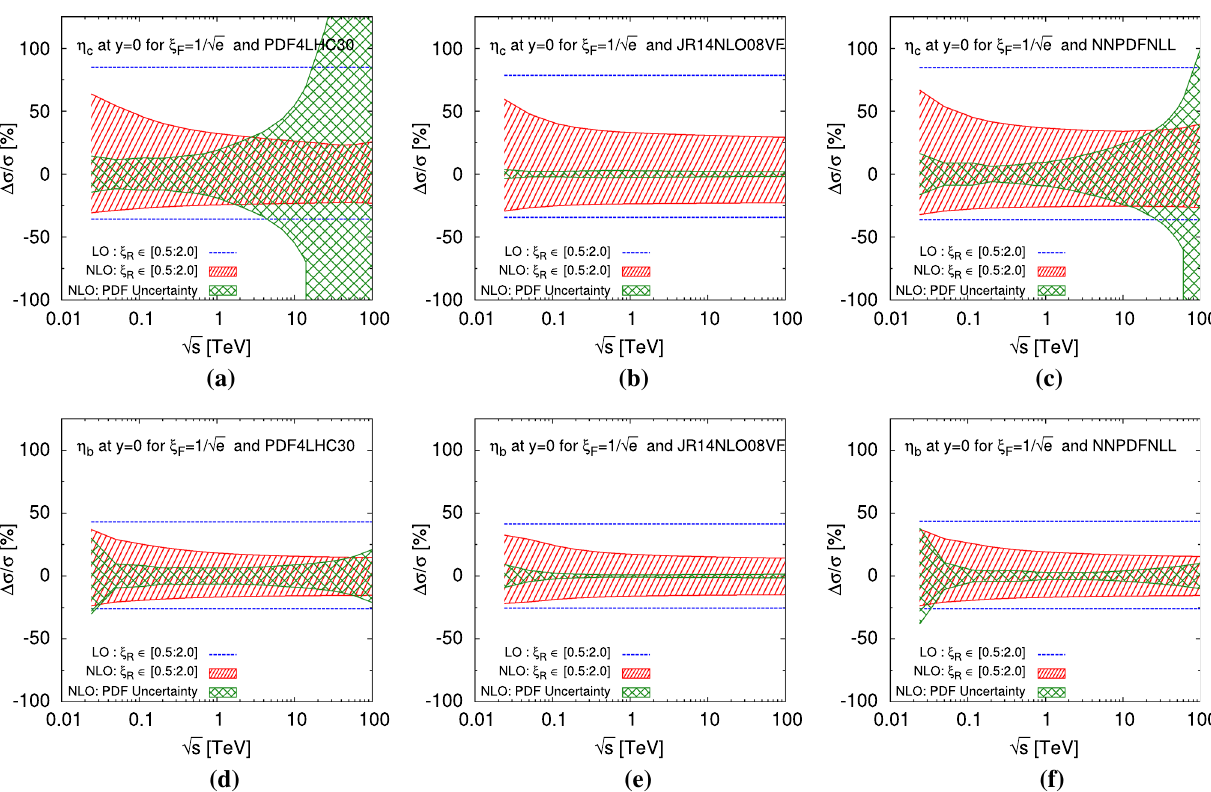
Fig. 10 Relative uncertainties (cid:20)σ/σ from μ R (for ξ R ∈ [ 0 . 5 : 2 ] ; red band) and PDF (for μ R = μ F ; green band) at NLO for η c (top) and η b √ s compared to the μ R uncertainty at LO for PDF4LHC (left), JR14NLO08VF (middle) and NNPDFsxNLONLL (right) (bottom) as a function of